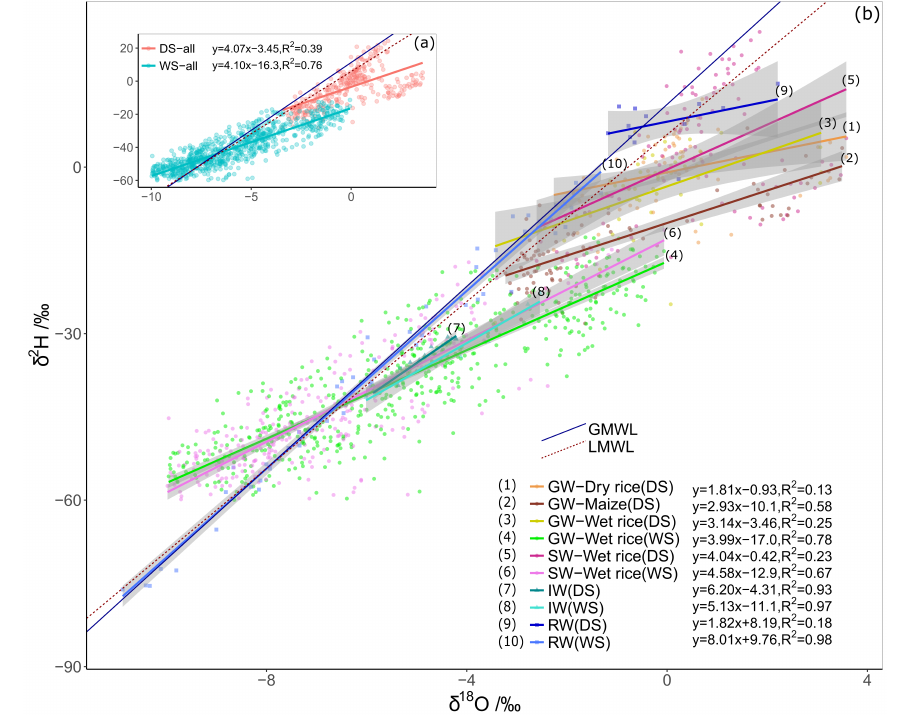
Figure 6. Dual ( δ 18 O, δ 2 H) isotope plots of water sources: all water during the wet (WS) and dry season (DS) ( a ), separated by different crops ( b ); groundwater (GW) of maize and wet and dry rice, surface water (SW) of wet rice during the dry season, and GW and SW of wet rice during the wet season with rainwater (RW) and irrigation water (IW) in comparison with the LMWL and GMWL. The gray shaded area represents the 95% confidence interval of the linear regression line. Slopes and the coefficients of determination (R 2 ) of the δ 18 O vs. δ 2 H linear regression for each water pool are